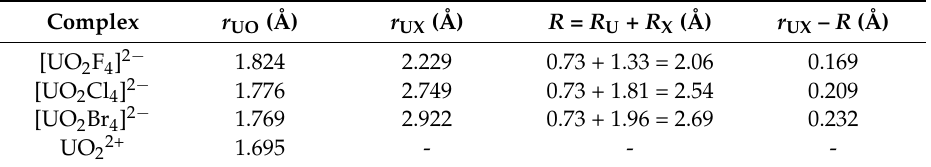
Table 3. B3LYP-calculated structural parameters [UO 2 X 4 ] 2 − . R = 6-coordinated Shannon ionic radius.